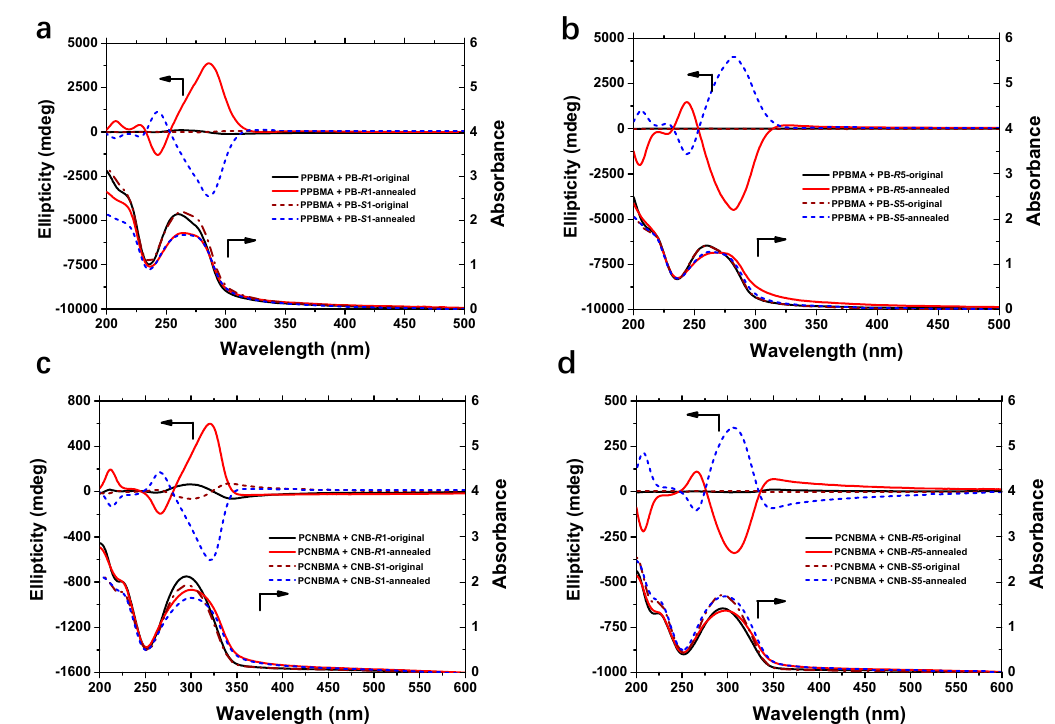
Figure 2. Chiral expression of the polymer films containing different components. ( a ) CD and UV-vis spectra of PPBMA 3 doped with PB- R/S 1. ( b ) CD and UV-vis spectra of PPBMA 3 doped with PB- R/S 5. ( c ) CD and UV-vis spectra of PCNBMA 3 doped with CNB- R/S 1. ( d ) CD and UV-vis spectra of PCNBMA 3 doped with CNB- R/S 5.